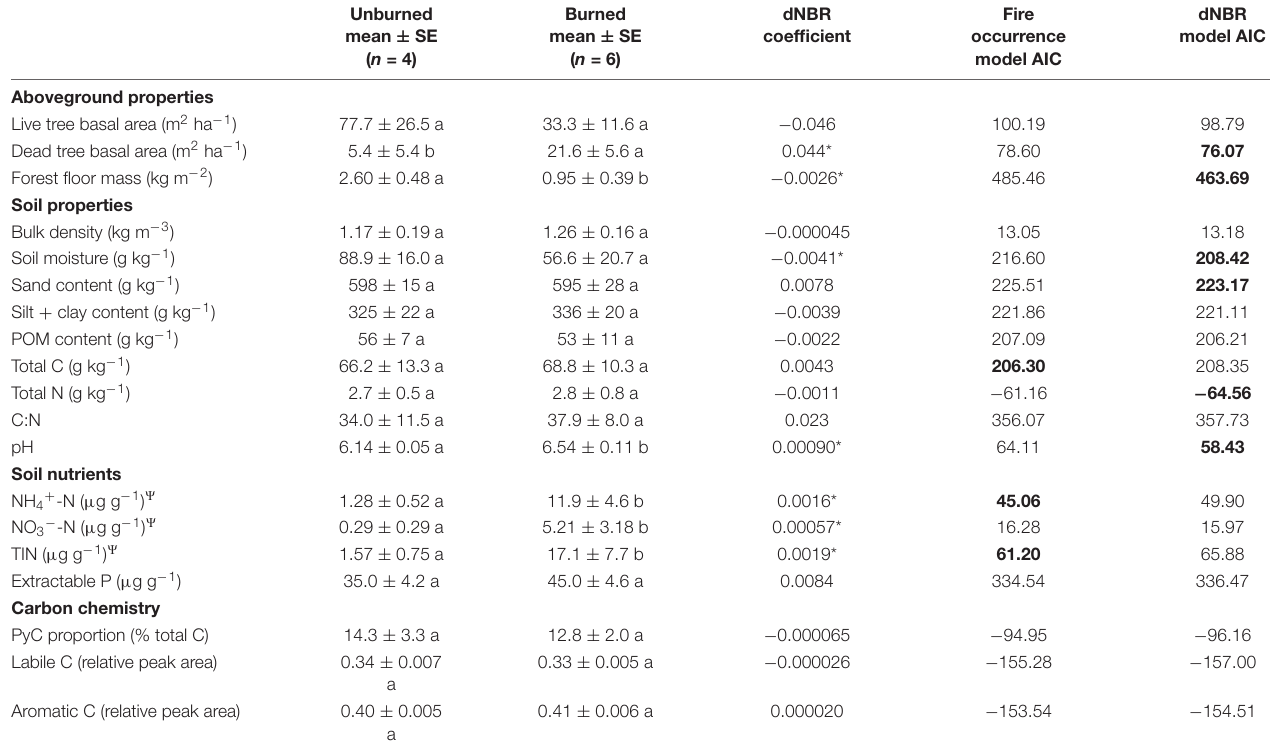
TABLE 1 | Relationship of fire occurrence and burn severity (dNBR) to soil properties as determined via linear mixed